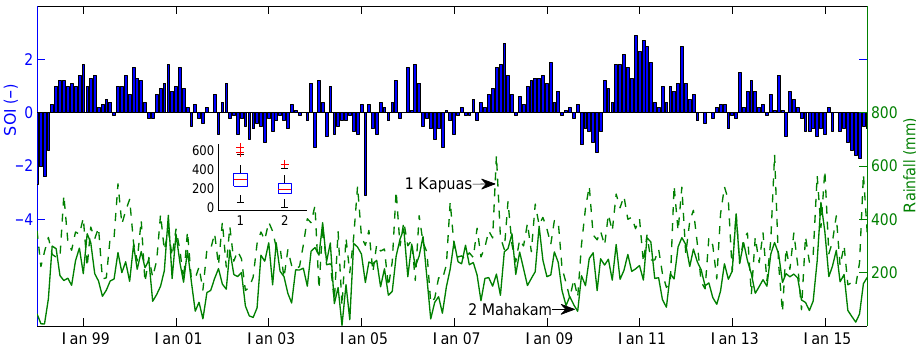
Figure 7. Monthly rainfall of the Kapuas (dashed line) and the Mahakam (continuous line) lowlands from January 1998 to December 2015 plotted along with the Southern Oscillation Index (bars). Box plots show the variability of monthly rainfall in the two lowland regions.